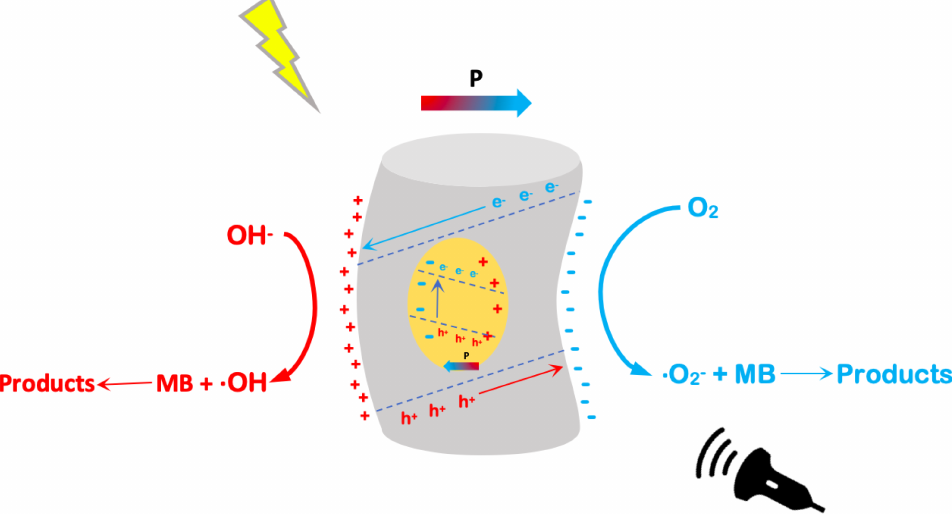
Figure 7. Piezo-photocatalysis of PVDF/BFO under light irradiation and ultrasonic vibration: pro- posed operating